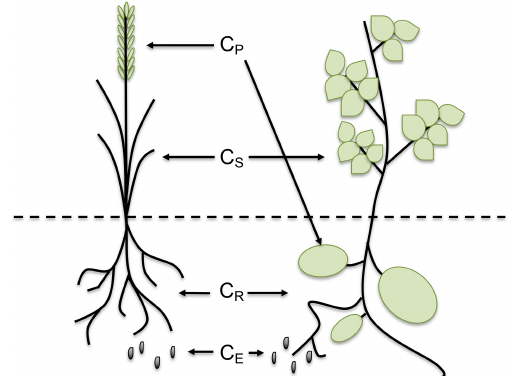
Figure 2. Adapted from Bolinder et al. (2007). Representation of the distribution of carbon in the different parts of the plant: C P rep- resents the carbon in the harvested product (grain, forage, tuber), C S is the carbon in the aboveground residue (straw, stover, chaff), C R is the carbon present in roots and C E represents all the extra-root carbon (including all root-derived materials not usually recovered in the root